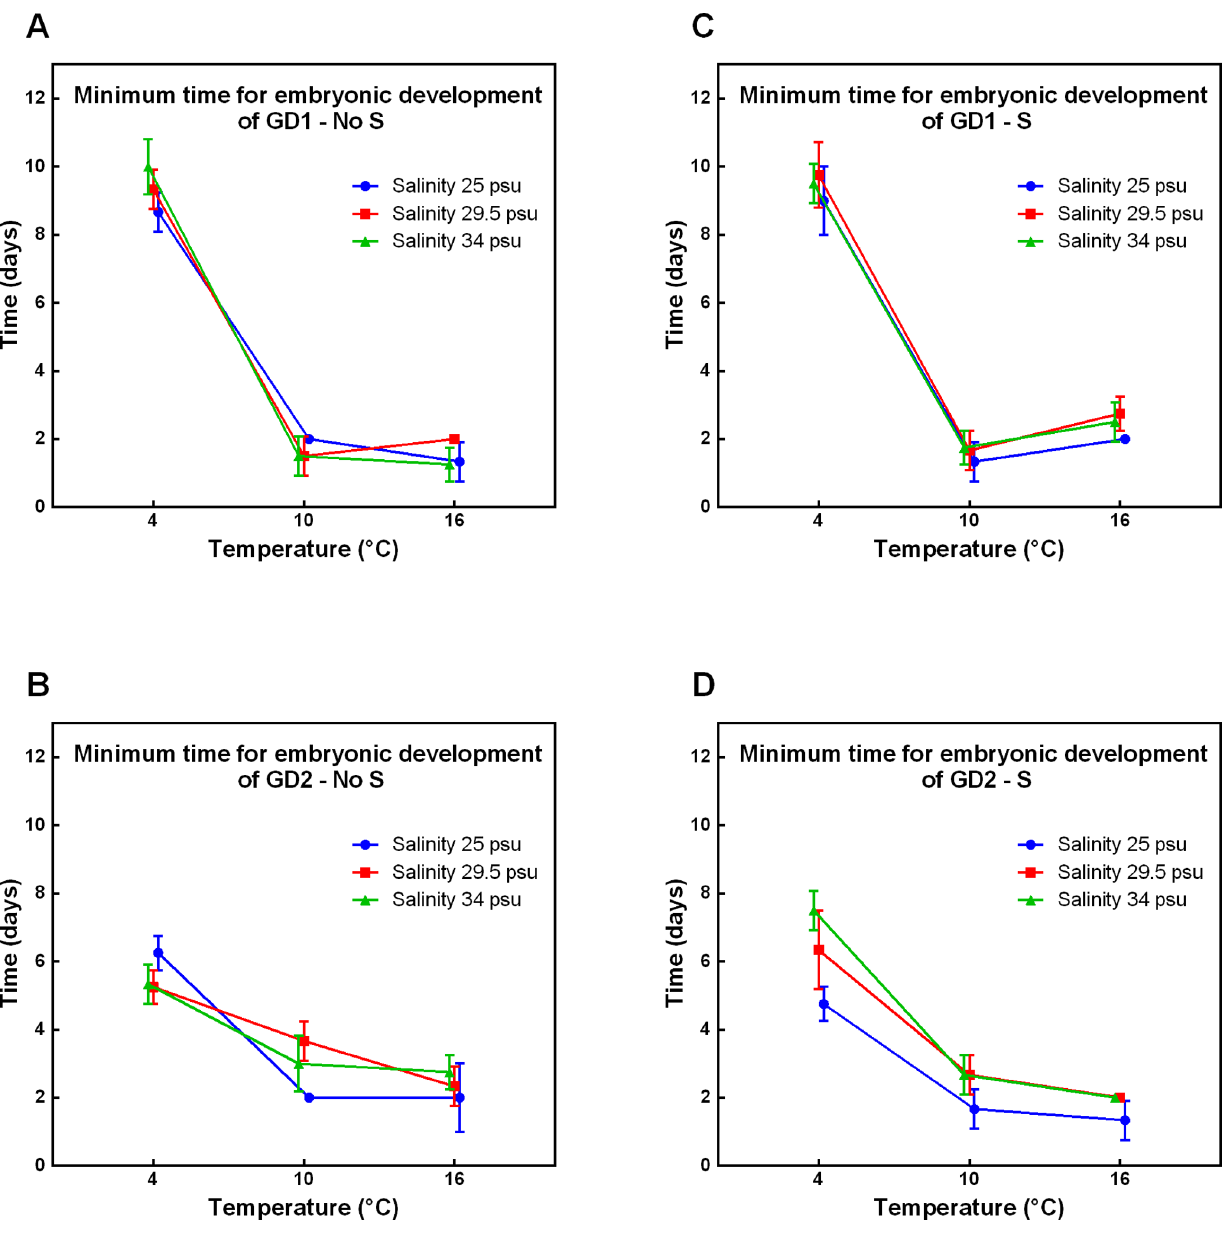
Figure 2. Minimum time for embryonic development of GD1 and GD2 under changing environmental conditions. Minimum time for embryonic development in relation to temperature and salinity of cryptic Halomonhystera disjuncta species: GD1 (A, C) and GD2 (B, D), in the absence (No S; A, B) and presence (S; C, D) of sulphide. The minimum time for embryonic development was calculated by subtracting the day we observed the first egg from the day we observed the first juvenile within the experimental microcosms. Data shown are mean values 6 1stdev of 3 or 4 replicates per treatment.